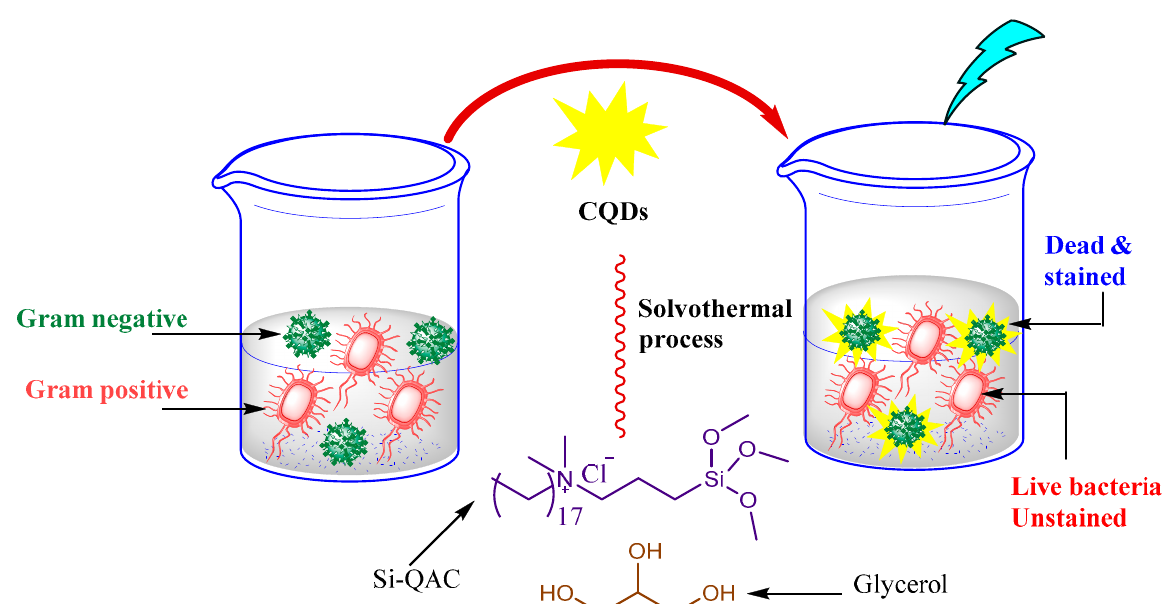
Figure 12. Quaternization of carbon dots formation and selective imaging potentiality against Gram-positive bacteria.